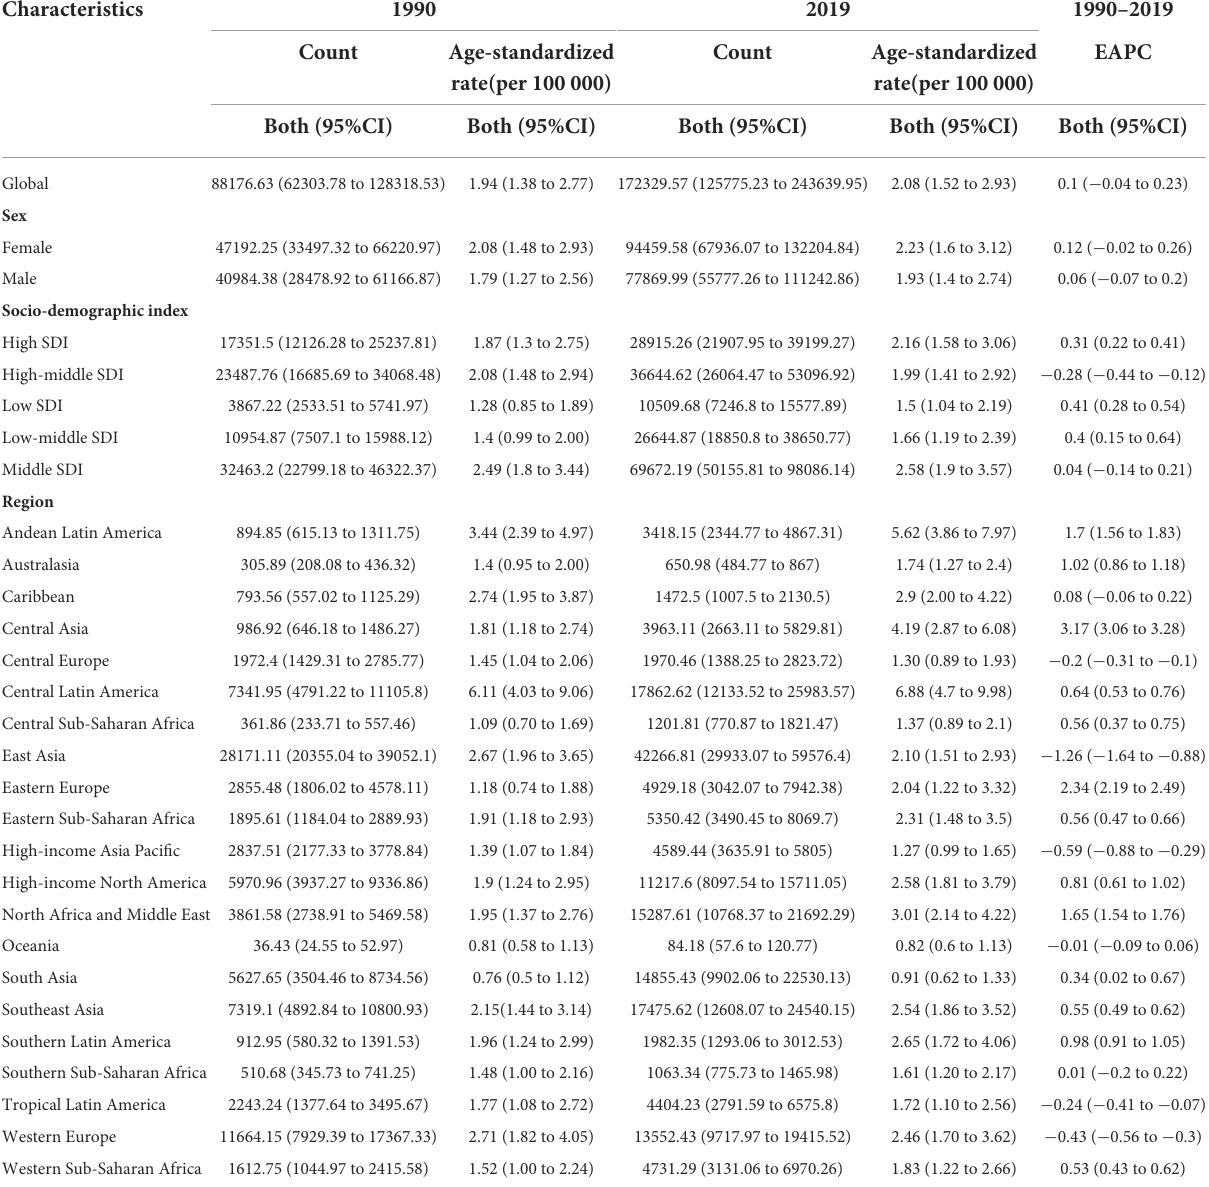
TABLE 1 The incident cases and ASIR in 1990 and 2019 and its temporal trends.